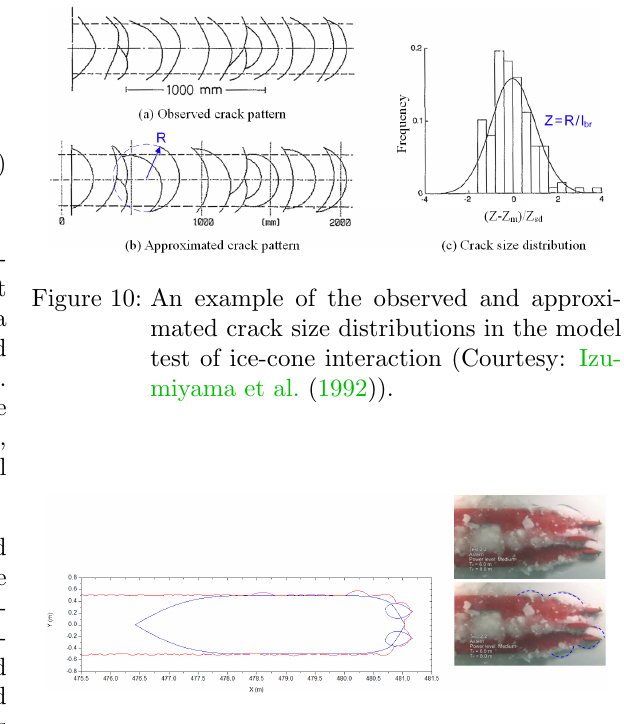
Figure 11: Simulated and observed icebreaking pat- terns, running astern in 33 mm (0 . 80 m full- scale) level